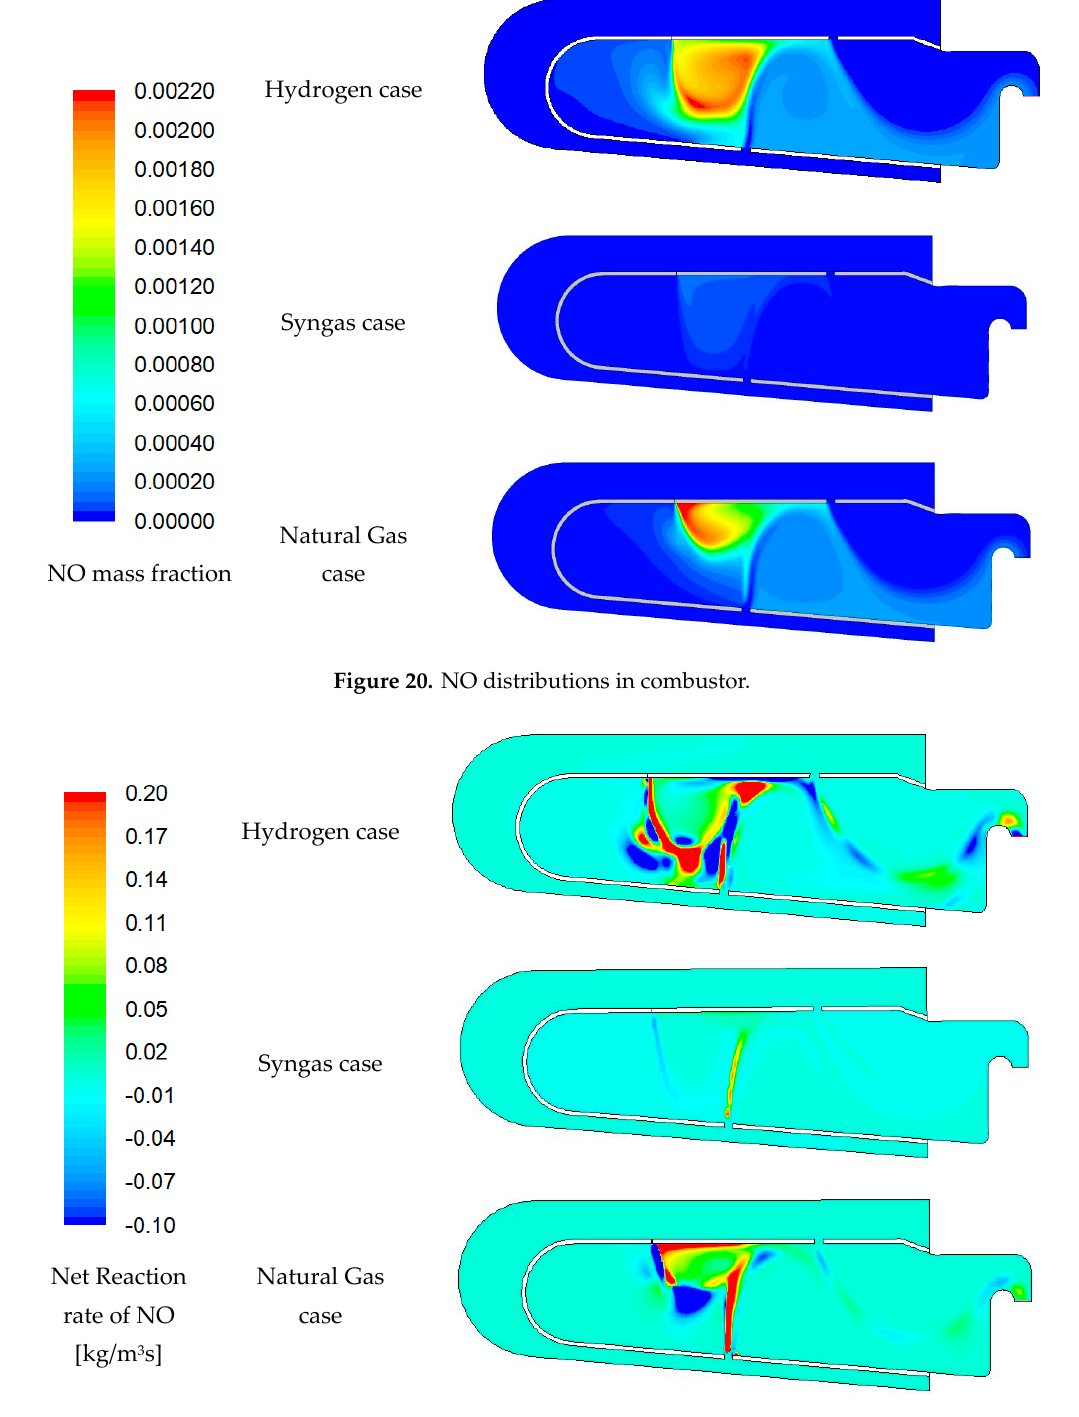
Figure 21. Net Reaction rate of NO distributions in combustor.